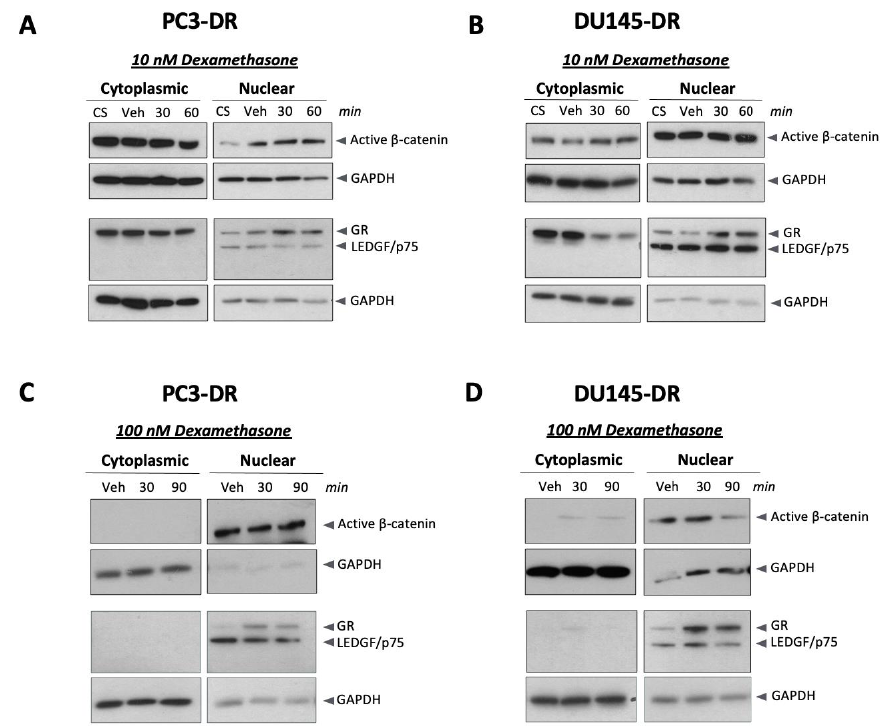
Figure 4. Nuclear localization of active β -catenin in DTX-resistant prostate cancer cells after dexamethasone treatment. Cells grown for 12 h in medium containing CS-FBS were then treated with 10 nM dexamethasone for the indicated times, and cytoplasmic and nuclear proteins were extracted for immunoblotting detection of GR and non-phosphorylated active β -catenin in ( A ) PC3-DR and ( B ) DU145-DR cells. A similar experiment was conducted using 100 nM dexamethasone in ( C ) PC3-DR and ( D ) DU145-DR cells. For these experiments, LEDGF/p75 and GAPDH were used as markers for nuclear and cytoplasmic fractions, respectively. CS—charcoal-stripped medium control; Veh—vehicle (ethanol) control. Blots are representative of 2 independent experiments.